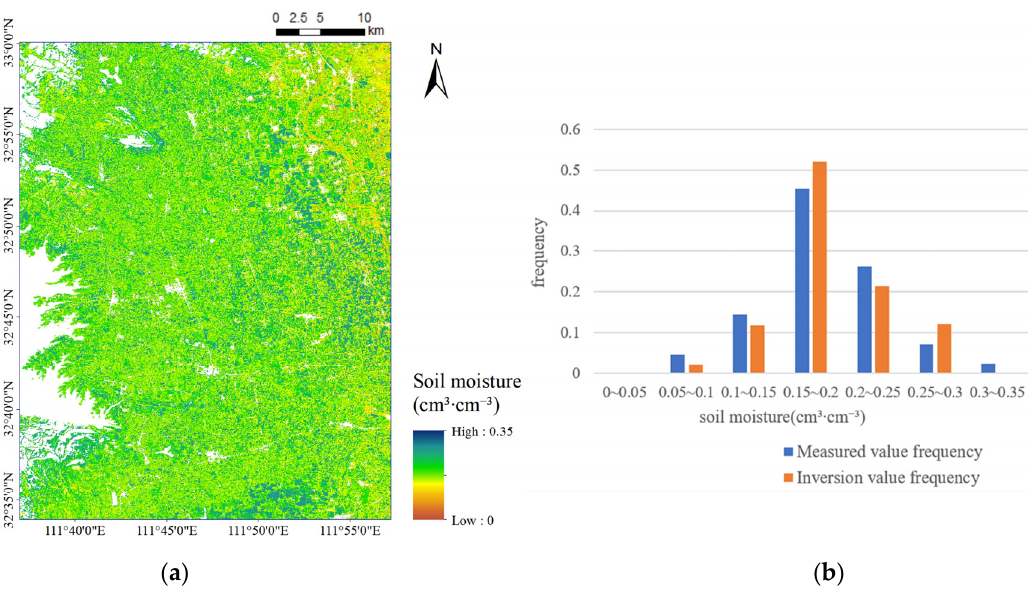
Figure 4. Inversion results of regional SSM in the study area on 11 September 2021: ( a ) spatial distribution of retrieved SSM; ( b ) frequency distribution of retrieved and measured SSM.